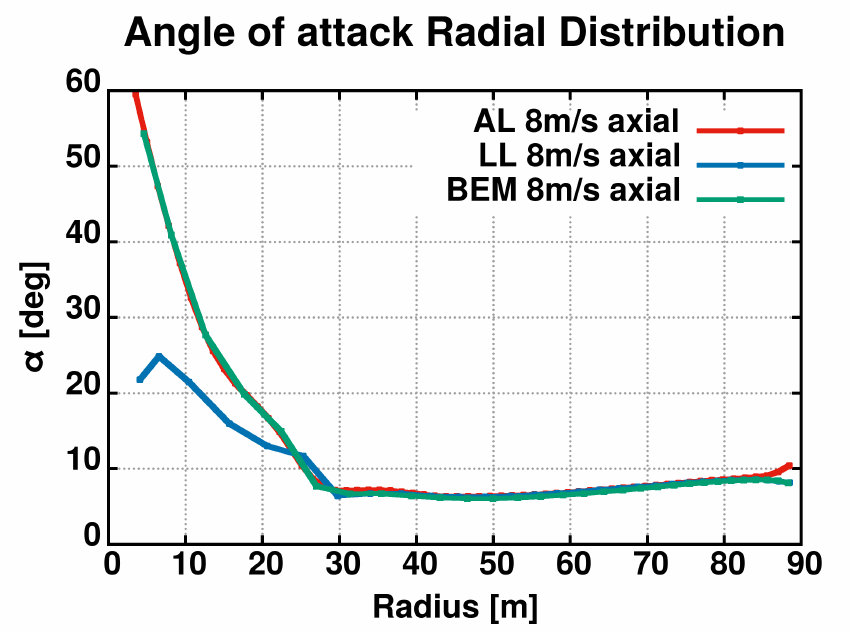
Figure 22. Angle of attack radial distribution at 8 m/s axial wind speed. Averaging over the final revolution of the